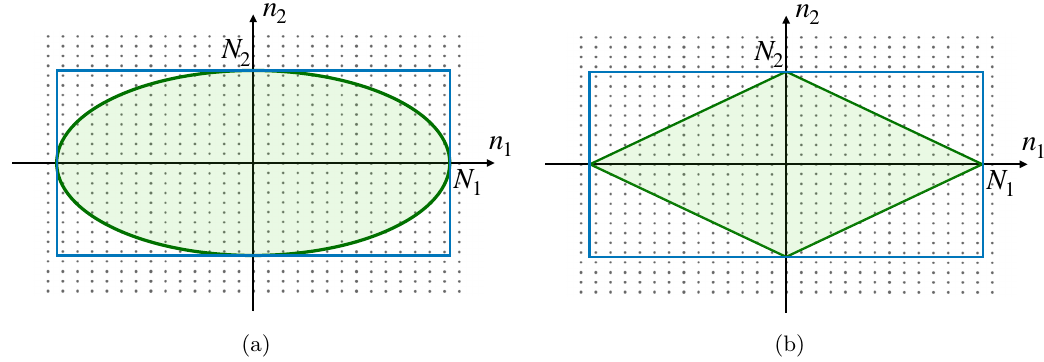
Figure 1 . Lattice of states for a light tower with two different mass scales. The states in each tower are labeled by the (positive) integers ( n 1 , n 2 ) . (a) Shows the case of two single KK towers (i.e. p 1 = p 2 = 1 ), whereas (b) displays the situation in the presence of two double KK towers (i.e. p 1 = p 2 = 2 ). The green line represents the limiting region where M = Λ UV , and its interior (shaded green region) contains all the states that lie below the cut-off and enter the EFT. The maximum excitation numbers N 1 and N 2 are given by the points where the limiting region cuts the axes. The blue rectangular contour shows the region we are using to approximate the states below the cut-off and it can be seen that for large number of species it differs from the green shaded region only by an order one